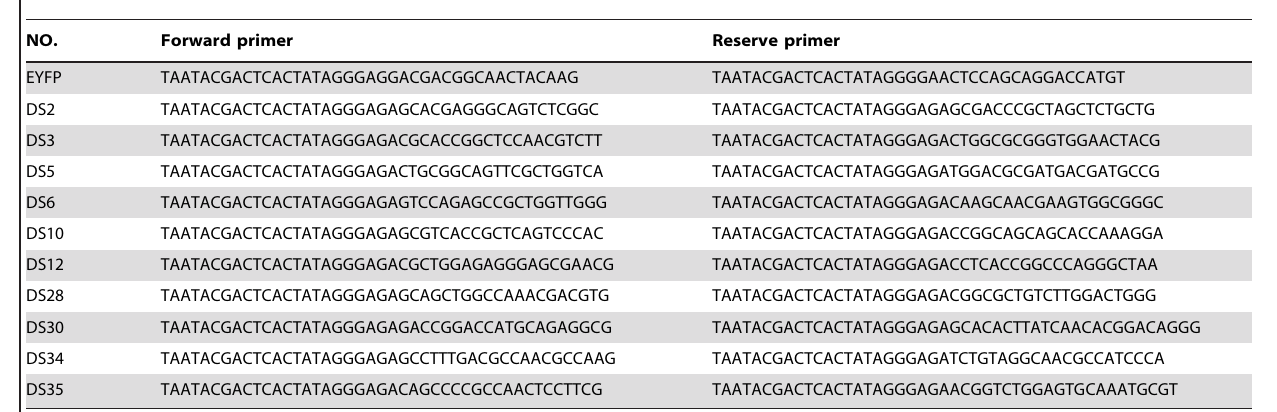
Table 7. The in vitro dsRNA synthesize with T7 tail primers of 10 larval stage specific genes.